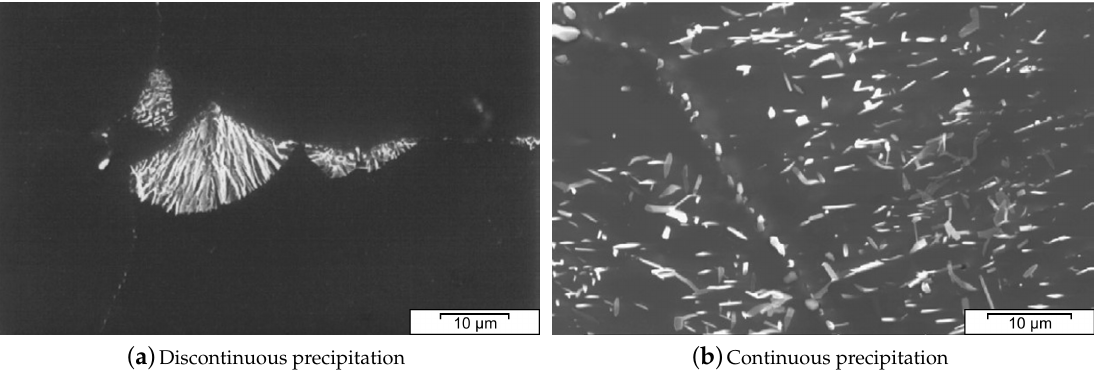
Figure 7. Scanning electron micrography (SEM) micrographs of homogenized and artificially aged AZ91, showing ( a )discontinuous and ( b )continuous precipitation [39]. Reproduced with permission from